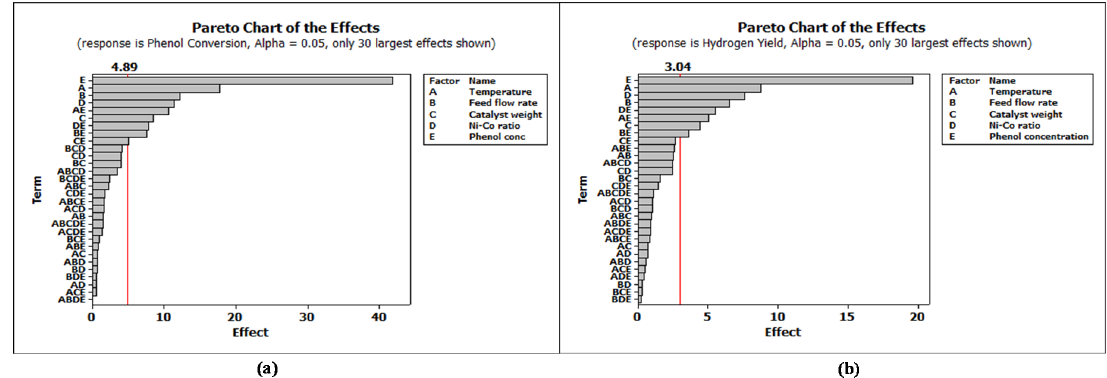
Figure 5. Pareto chart for ( a ) Y 1 and ( b ) Y 2 .